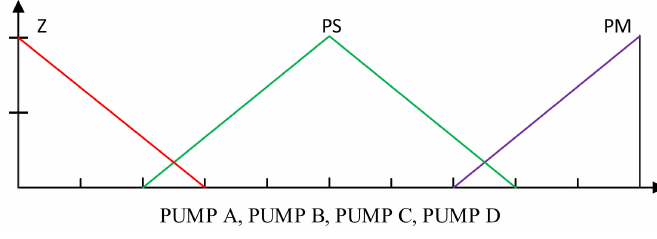
Figure 5. Pump membership